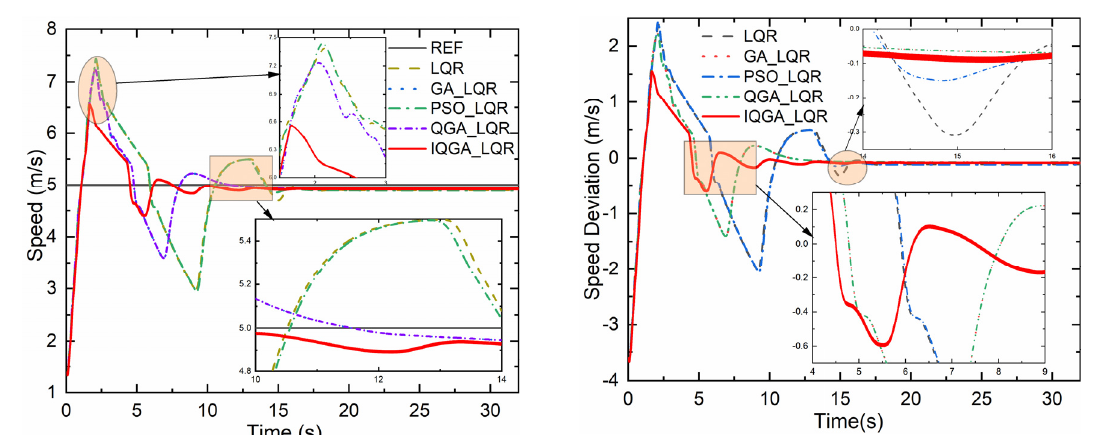
Figure 8. Tractor speed and deviation.